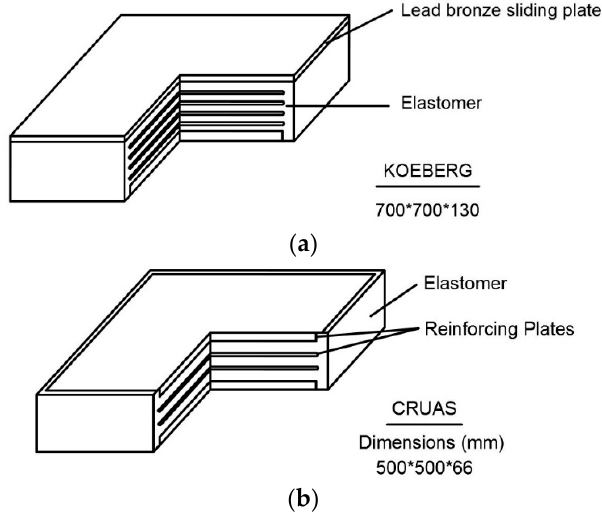
Figure 2. ( a ) Koeberg elastomeric bearing with a sliding plate; ( b ) Bearing used in the Cruas, France nuclear power plant [5].